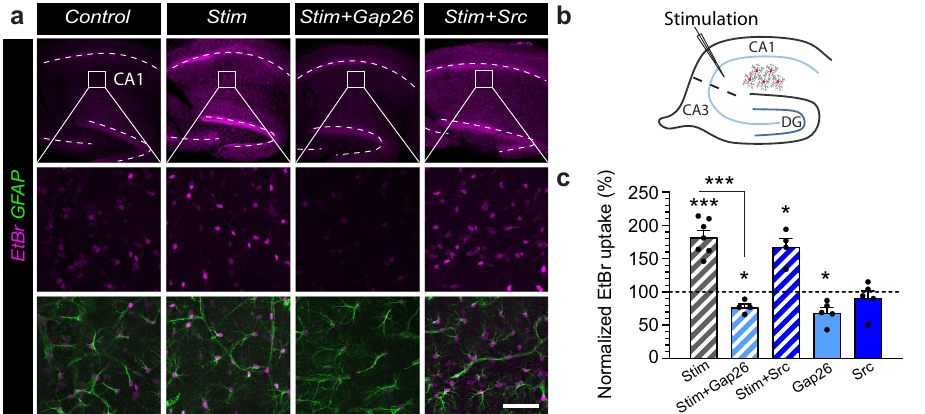
Fig. 6 Cx43 hemichannel function is enhanced by synaptic activity. Acute hippocampal slices were loaded with ethidium bromide (EtBr) under different experimental conditions. a Sample images of EtBr uptake (magenta) in hippocampal GFAP-immunolabeled astrocytes (green) are shown for Control, Stim (10 Hz, 30 s every 3 min for 20 min) in the absence or presence of the Cx43 HC blocker Gap26 or a Gap26 scramble version (Src). Higher magni fi cations of the CA1 stratum radiatum subregion are shown in bottom two rows. b Schematic illustrating stimulation of hippocampal Schaffer collaterals and EtBr